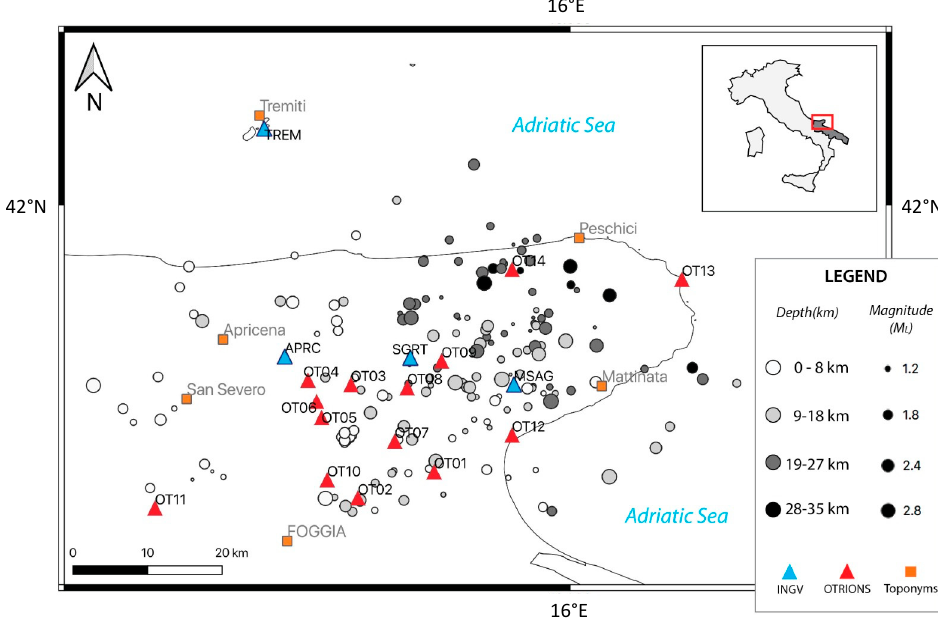
Figure 2. An overview map of the seismic networks (red triangle of OT and blue triangles for IV) and the selected earthquakes (circle dimension is proportional to magnitude, circle color to depth, as indicated in the legend). The map was produced using the QGIS open-source software [36]. For OT and IV stations, please refer to [37] and [32] , respectively.